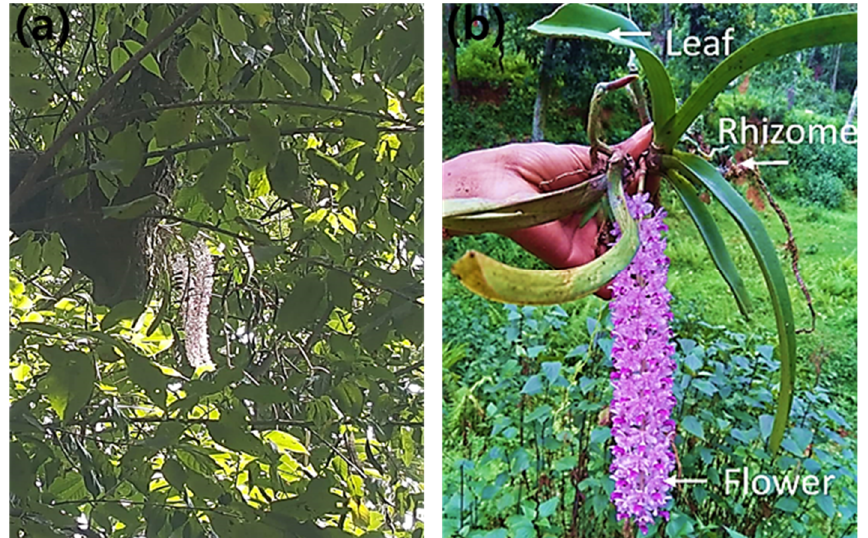
Figure 1. ( a ) Rhynchostylis retusa in the host tree, ( b ) Rhynchostylis retusa showing Rhizome, leaf, and flower. and